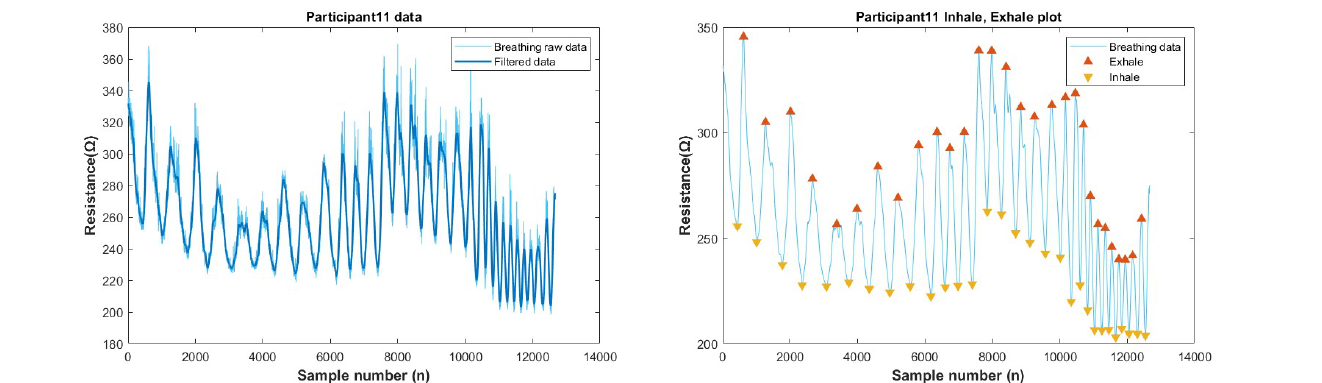
Figure A26. Breathing Test data of Participant number-11.